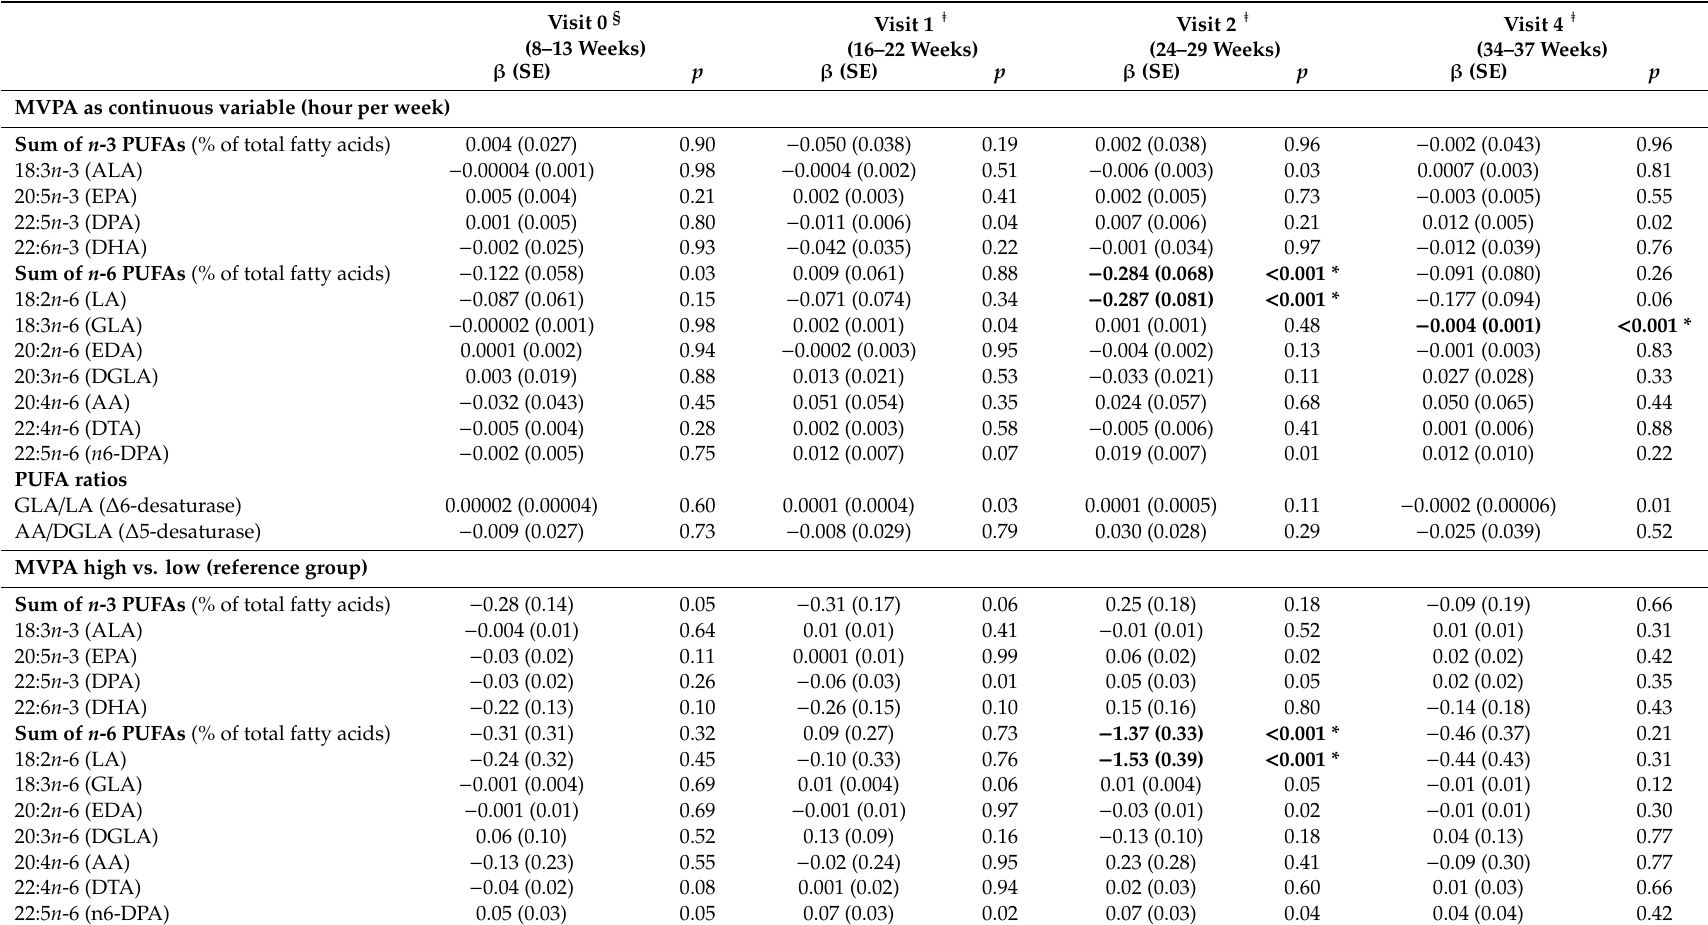
Table 2. Time-specific associations of maternal moderate-to-vigorous physical activity (MVPA) and plasma phospholipid polyunsaturated fatty acids (PUFAs) at each study visits in the NICHD Fetal Growth Studies–Singleton Cohort.